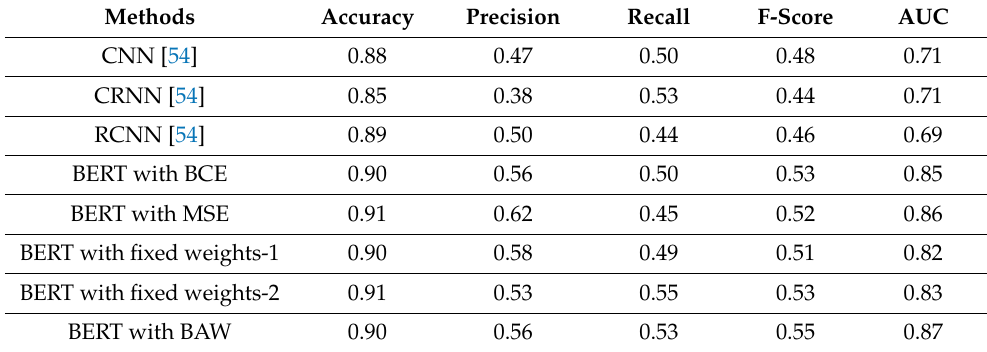
Table 8. Results by deep learning